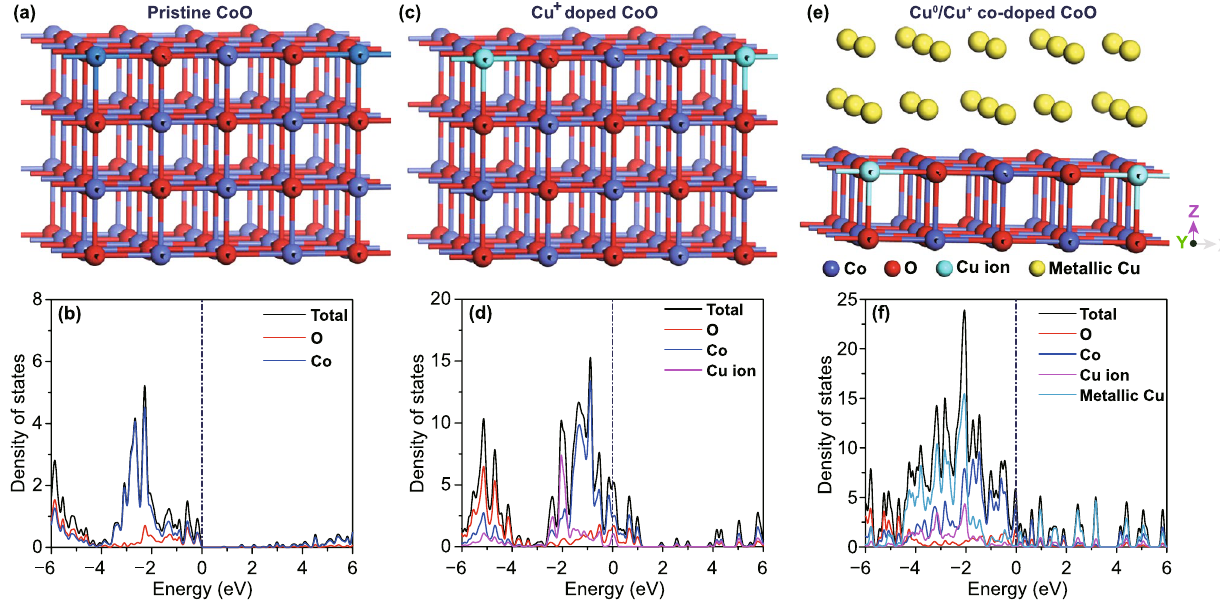
Fig. 6 Atomic structure models and DFT calculation of the DOS for a , b pristine CoO, c , d Cu + -doped CoO and e , f Cu 0 /Cu + co-doped